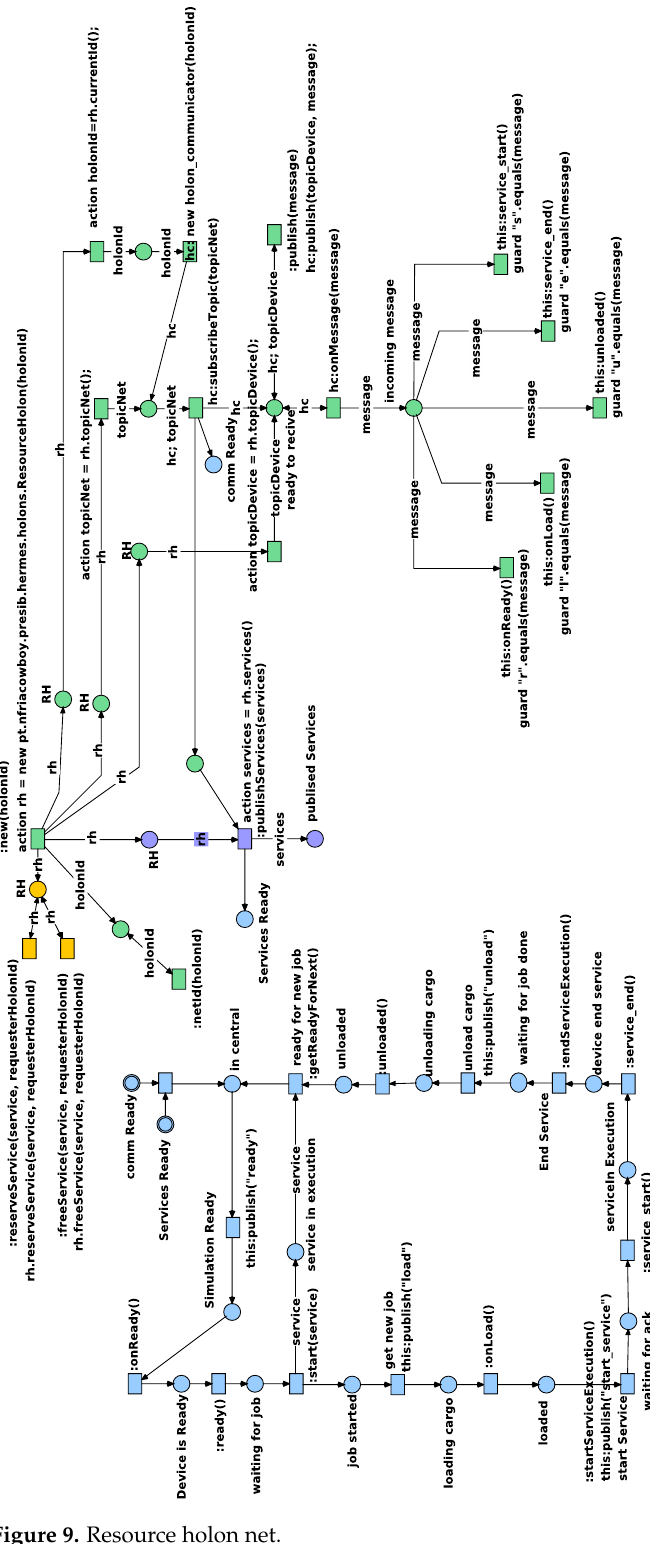
Figure 9. ResourceHolon net Figure 9. Resource holon